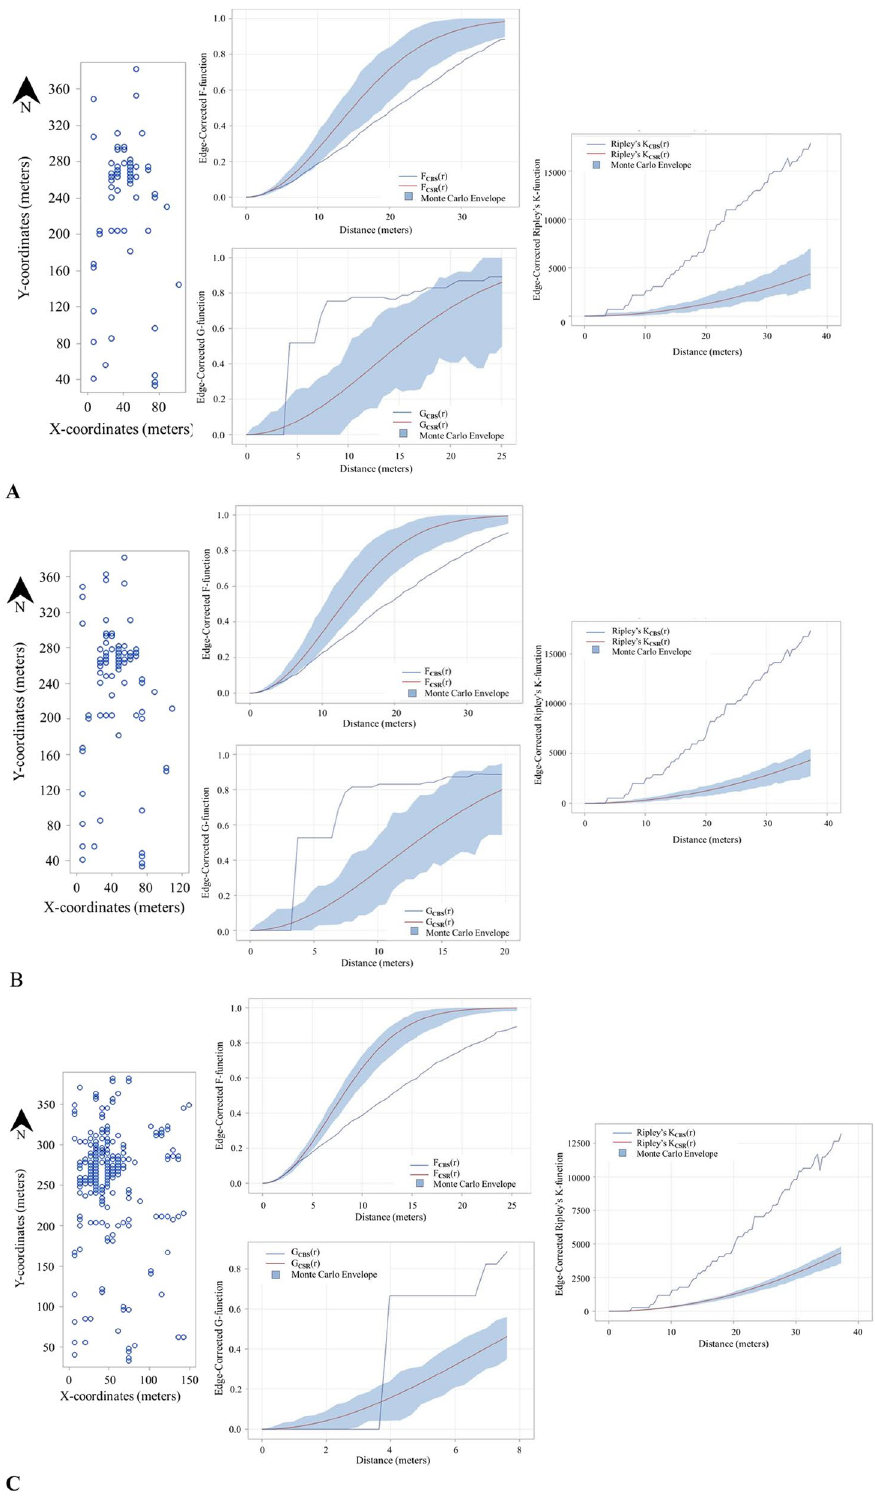
Figure 1. Grove I point pattern analyses. Comparisons of point pattern analyses for Grove I for three contiguous citrus seasons (Panel A) 2013–2014, (Panel B) 2014–2015 and (Panel C) 2015–2016. Each panel consists of a plot map of CBS positive trees (open circles; left), edge-corrected F- and G-functions (middle) and edge-corrected Ripley’s K-function (right). Positive trees contain at least one fruit with a single hard-spot lesion. Values of F CBS (r) < F CSR (r), and of G CBS (r) > G CSR (r) that falls outside of the Monte Carlo envelopes, indicate statistically significant clustering. For each graph, the red line corresponds to a Poisson process representing complete spatial randomness (CSR) and the blue shaded area is the Monte Carlo envelope that corresponds to the 5th to 95th percentiles of CSR, F(r), G(r) and Ripley’s K(r) respectively for values based on randomizations of the original